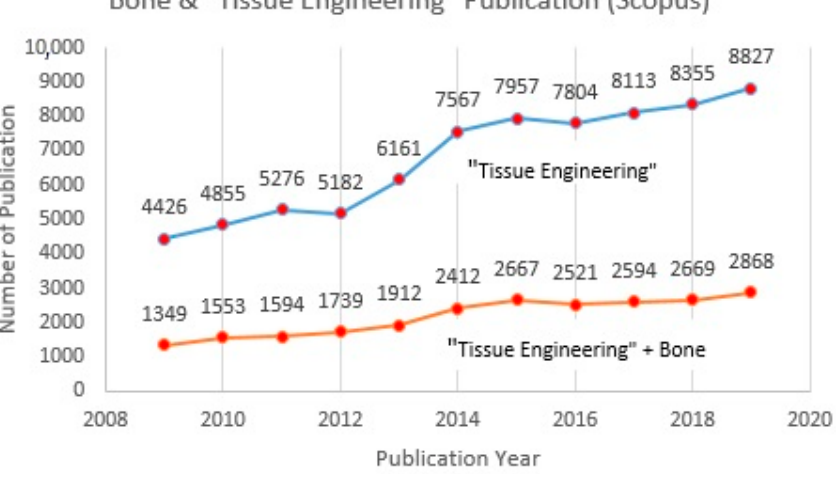
Figure 2. Published articles for tissue engineering and bone in Scopus database (2009–2019).